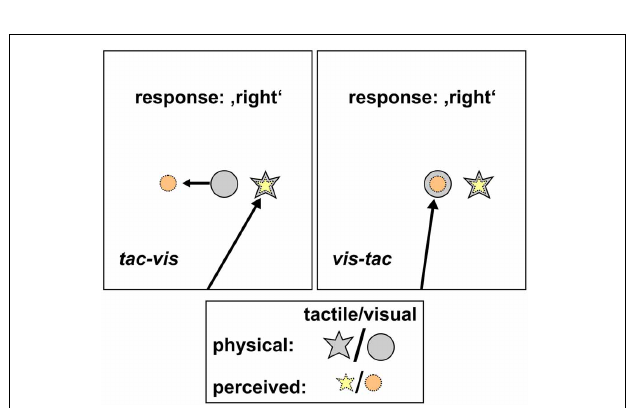
comparison were presented sequentially. (B) Shifted-gaze: subjects foveated the tactile standard, then shifted gaze toward the fixation location where it was held while the visual comparison was presented. (C) Control: subjects foveated the tactile standard and held gaze at this location while the visual comparison was presented.